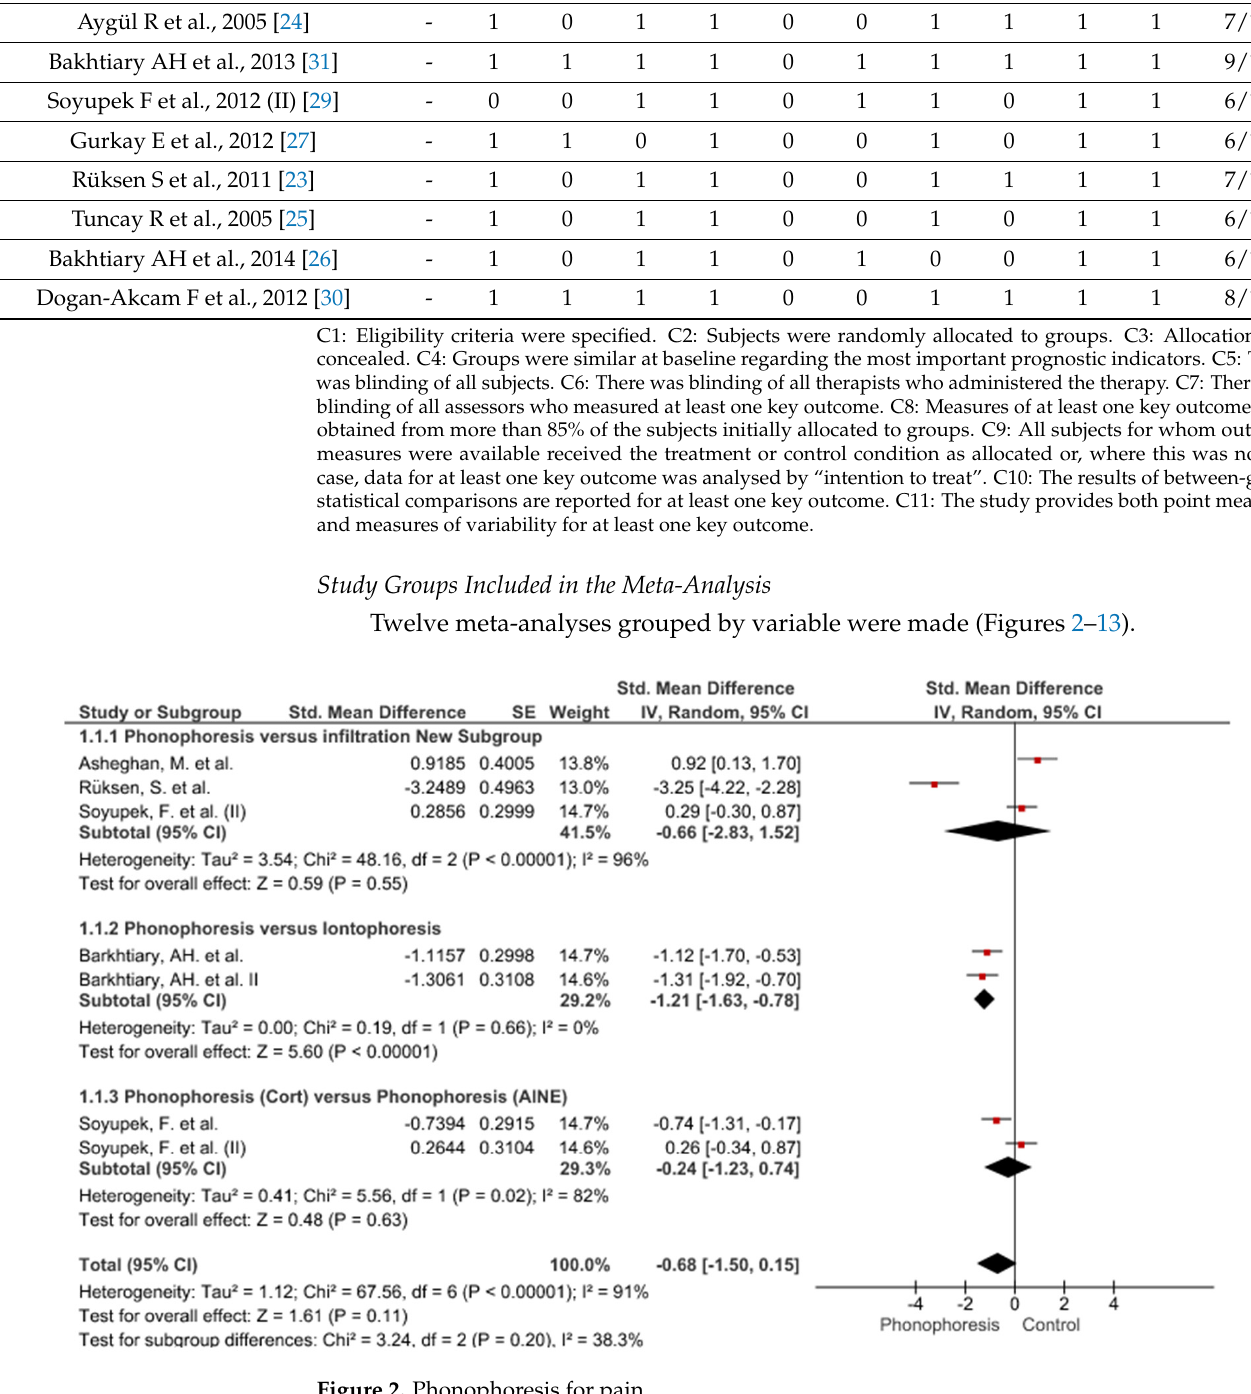
Figure 2. Phonophoresis for pain.